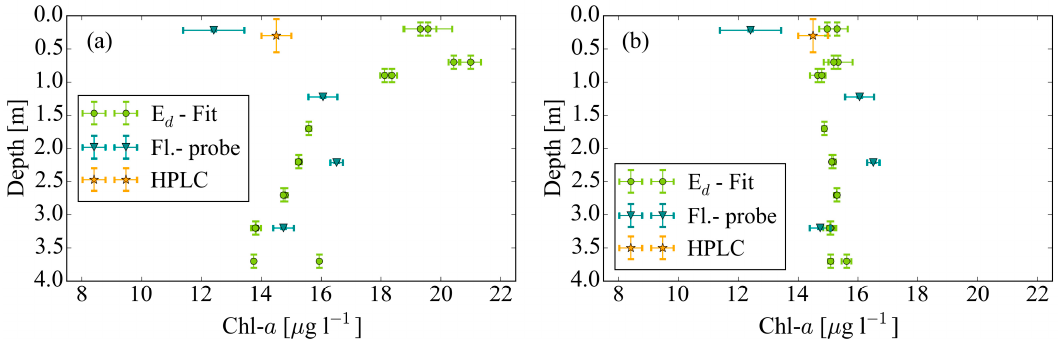
Figure 3. ( a ) Comparison of Chl -a concentration from in-water irradiance measurements (Ramses setup) with results from bbe probe scans with fixed sensor depth. ( b ) Retrieval results with varied sensor depth z . Two dots at a given depth represent two measured sets of 30 spectra each.